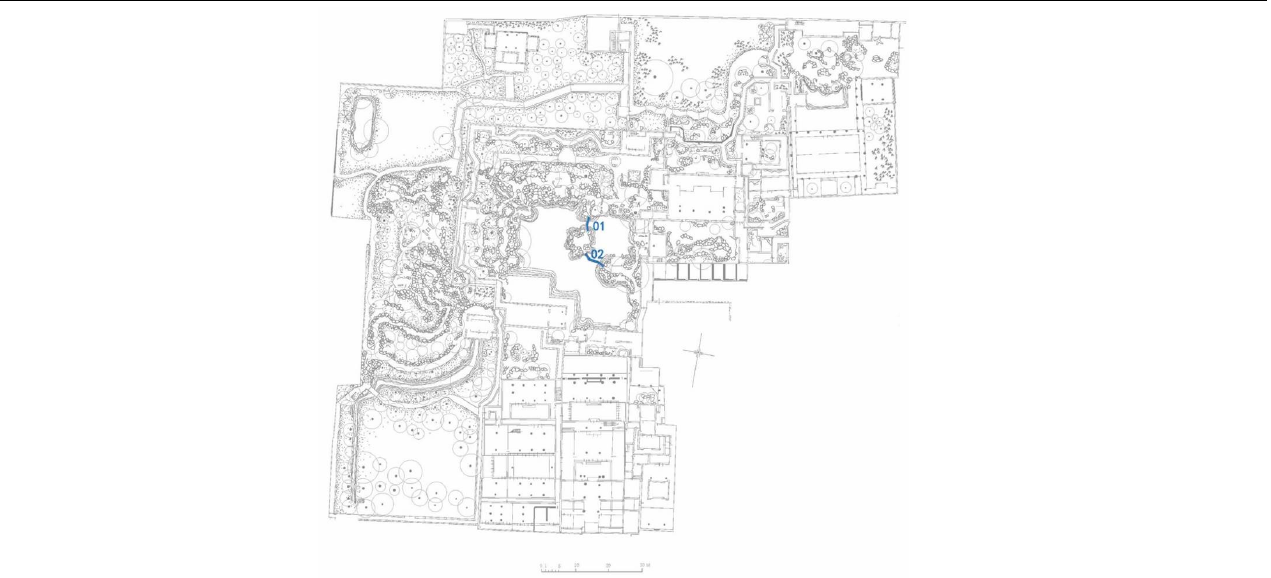
Table A21. Lingering Garden,